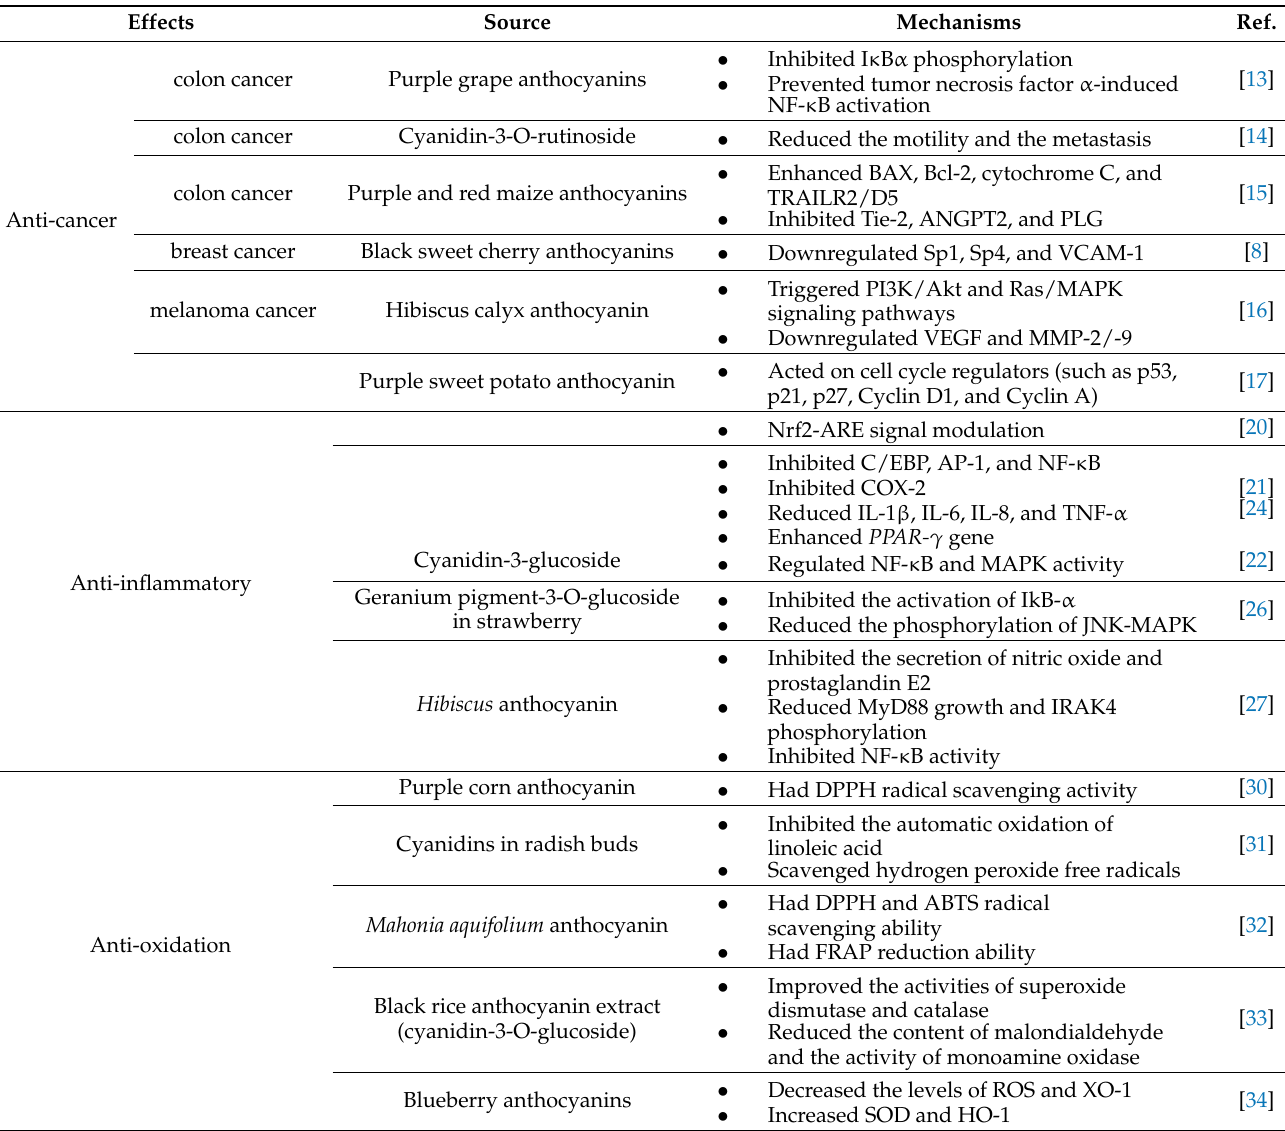
Table 2. Physiological activities of